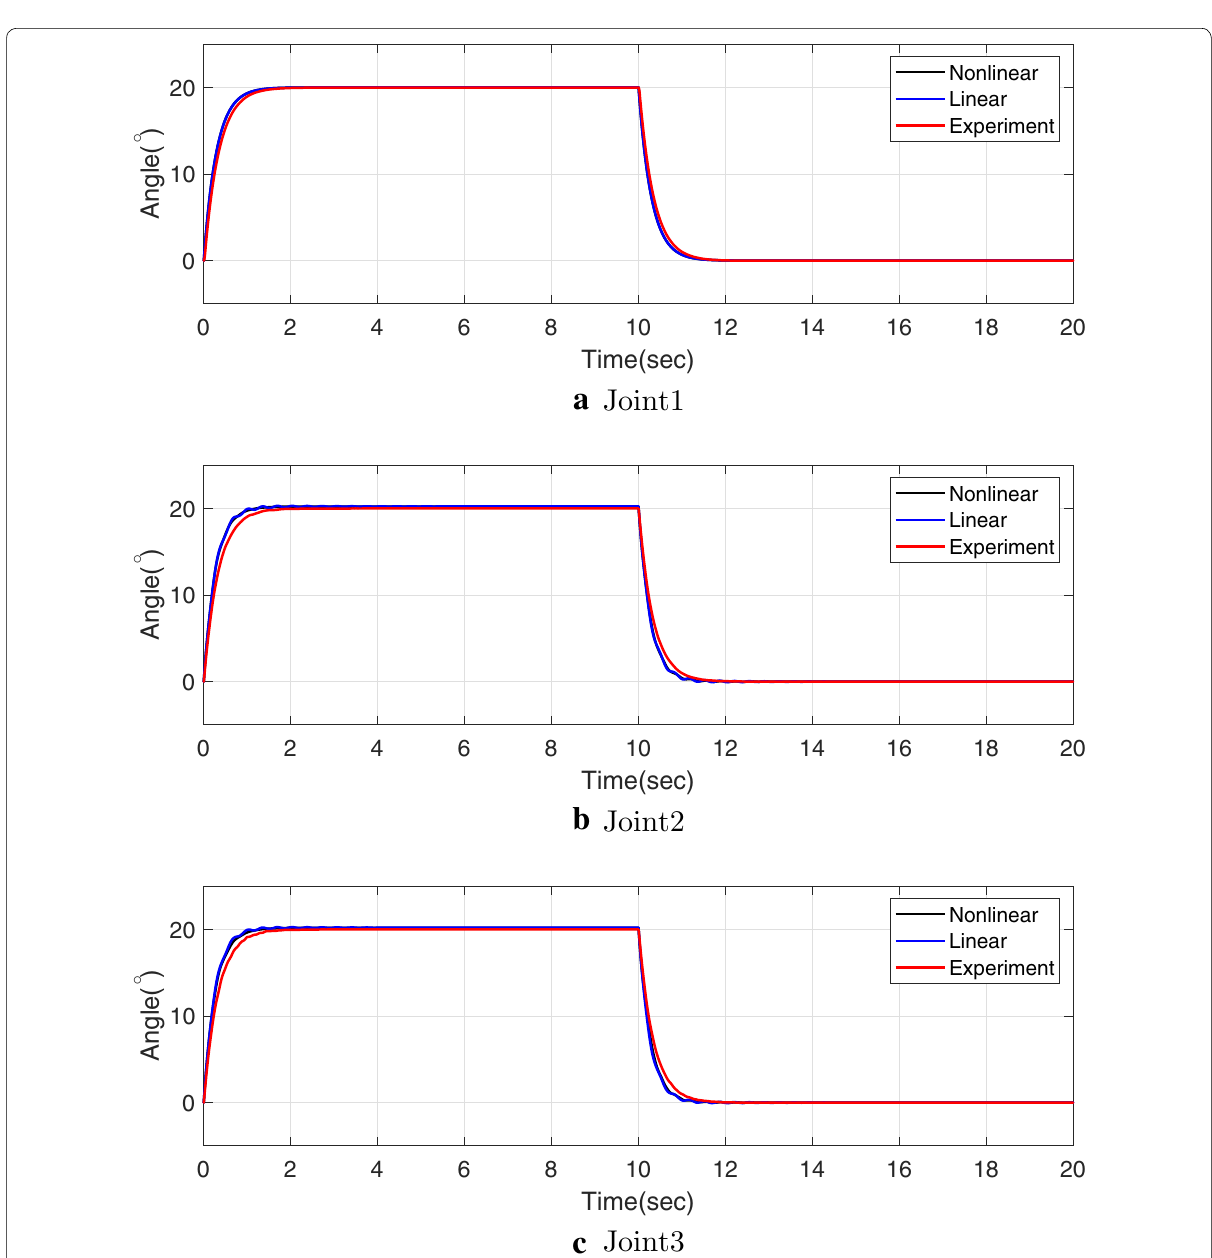
Fig. 3 Validation of joint angles. This figure shows the joint trajectories of the nonlinear model and the linearized model against the actual